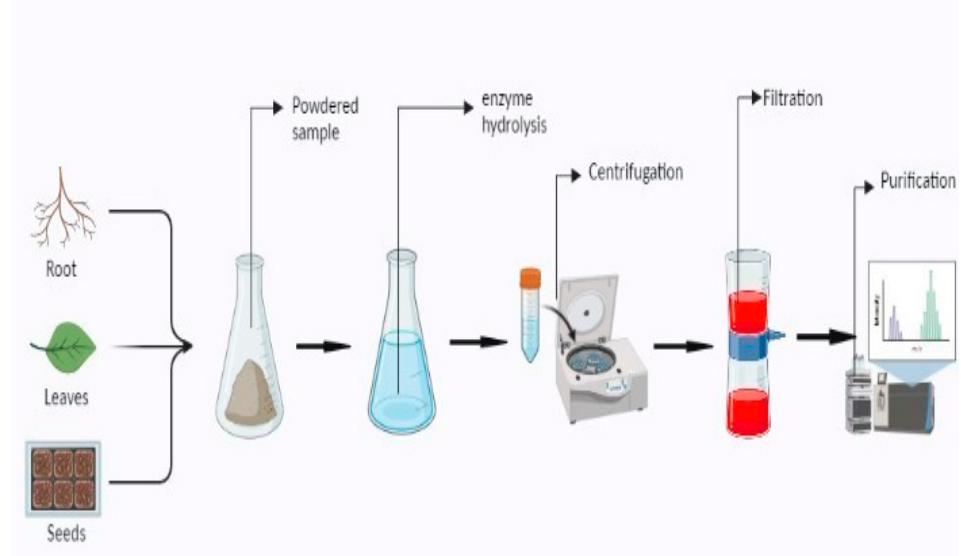
Figure 10. A diagrammatic representation of enzyme-assisted extraction.